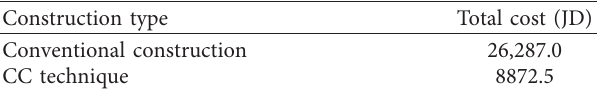
Table 4: Material cost comparison between conventional con- struction and CC